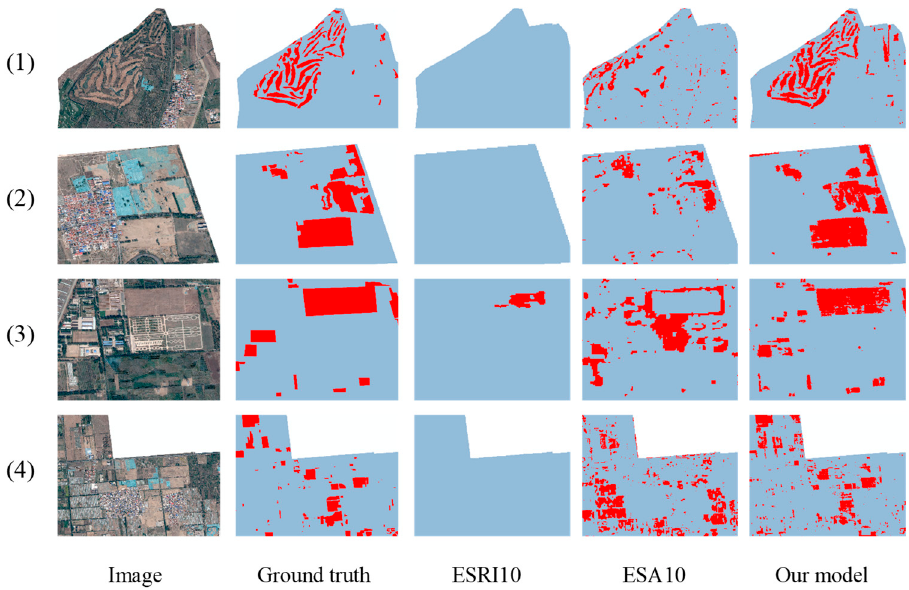
Figure 17. Di ff erent results for bare land for the di ff erent classi fi cations: (1–4) Four typical